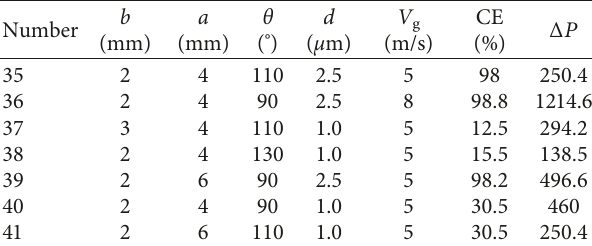
Table 3: Analysis of variance of collection efficiency.